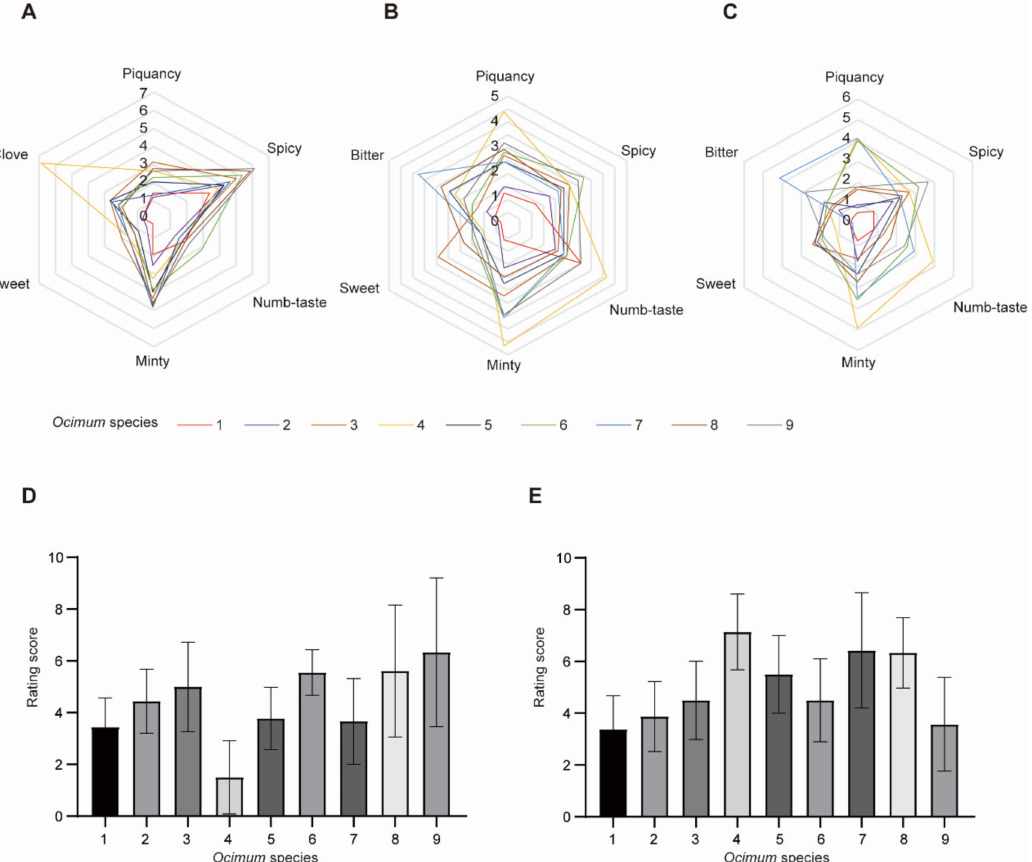
Figure 2. Sensory evaluation of different basil species. ( A – C ): Orthonasal evaluation, retronasal evaluation without heat treatment and retronasal evaluation with heat treatment, respectively. ( D , E ): Rating score of overall intensity of basils in orthonasal evaluation and retronasal evalu- ation without heat treatment, respectively. Data are represented as mean ± SD, each included nine